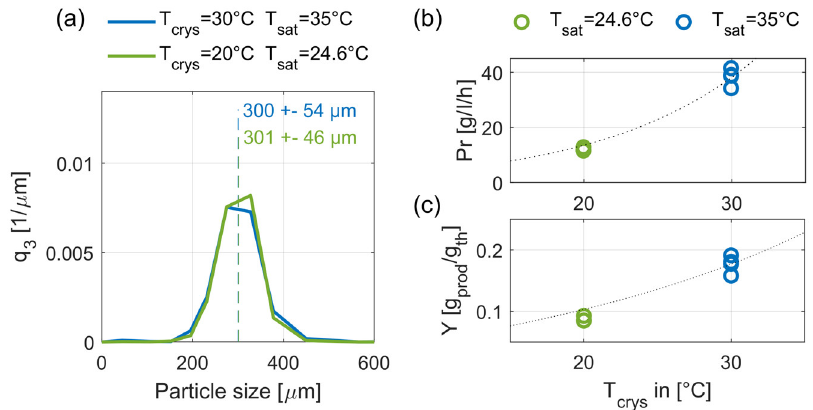
Figure 10. Mean steady-state crystal size distributions, q 3 , with their respective mean values and standard deviations ( a ), productivities, Pr ( b ), and yields, Y ( c ), for two different crystallization temperatures, T crys = 20 and 30 °C, at the same supersaturation and volumetric flowrate. The dotted lines ( b ) indicate the change with respect to the central point at T crys = 30 °C, assuming the withdrawn product mass is proportional to the growth rate [19]. Given results are from crystallizer C2 for Exps. 4,